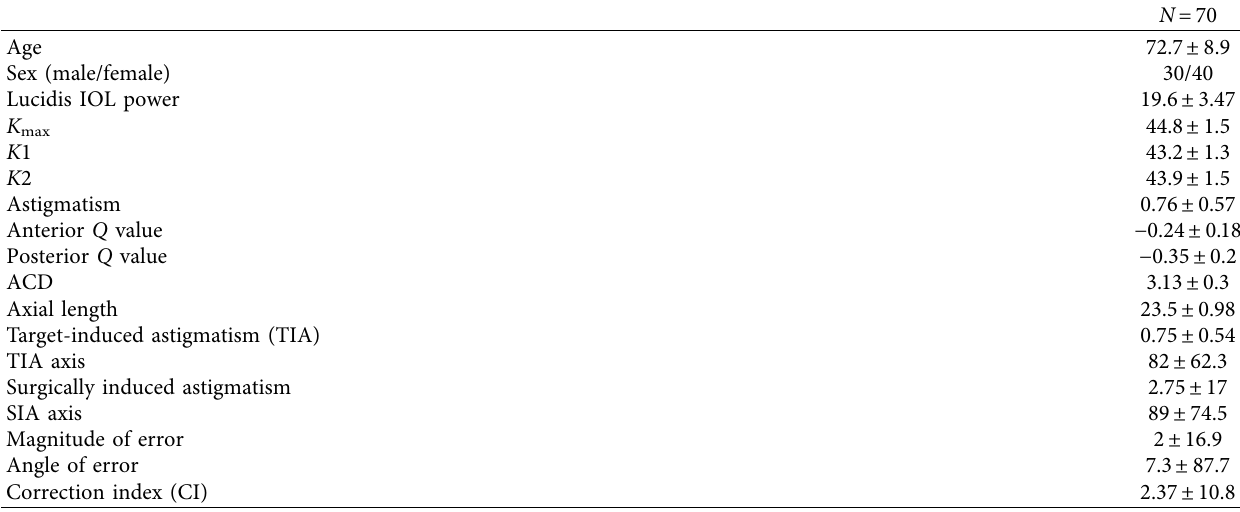
Table 1: Demography of population.